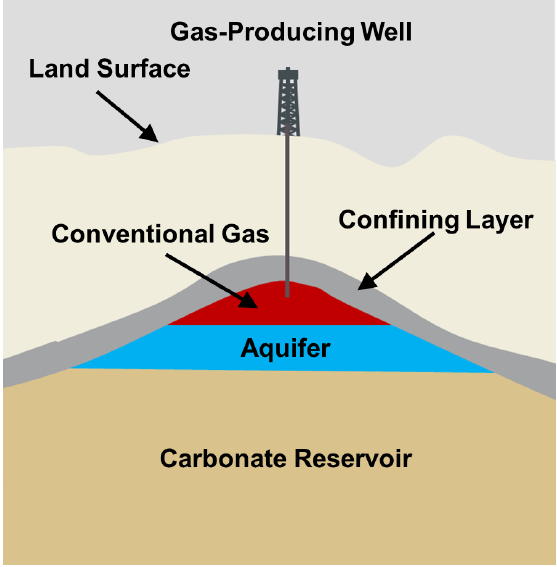
Figure 1. Schematic diagram of a vertical gas-producing well in a carbonate reservoir.